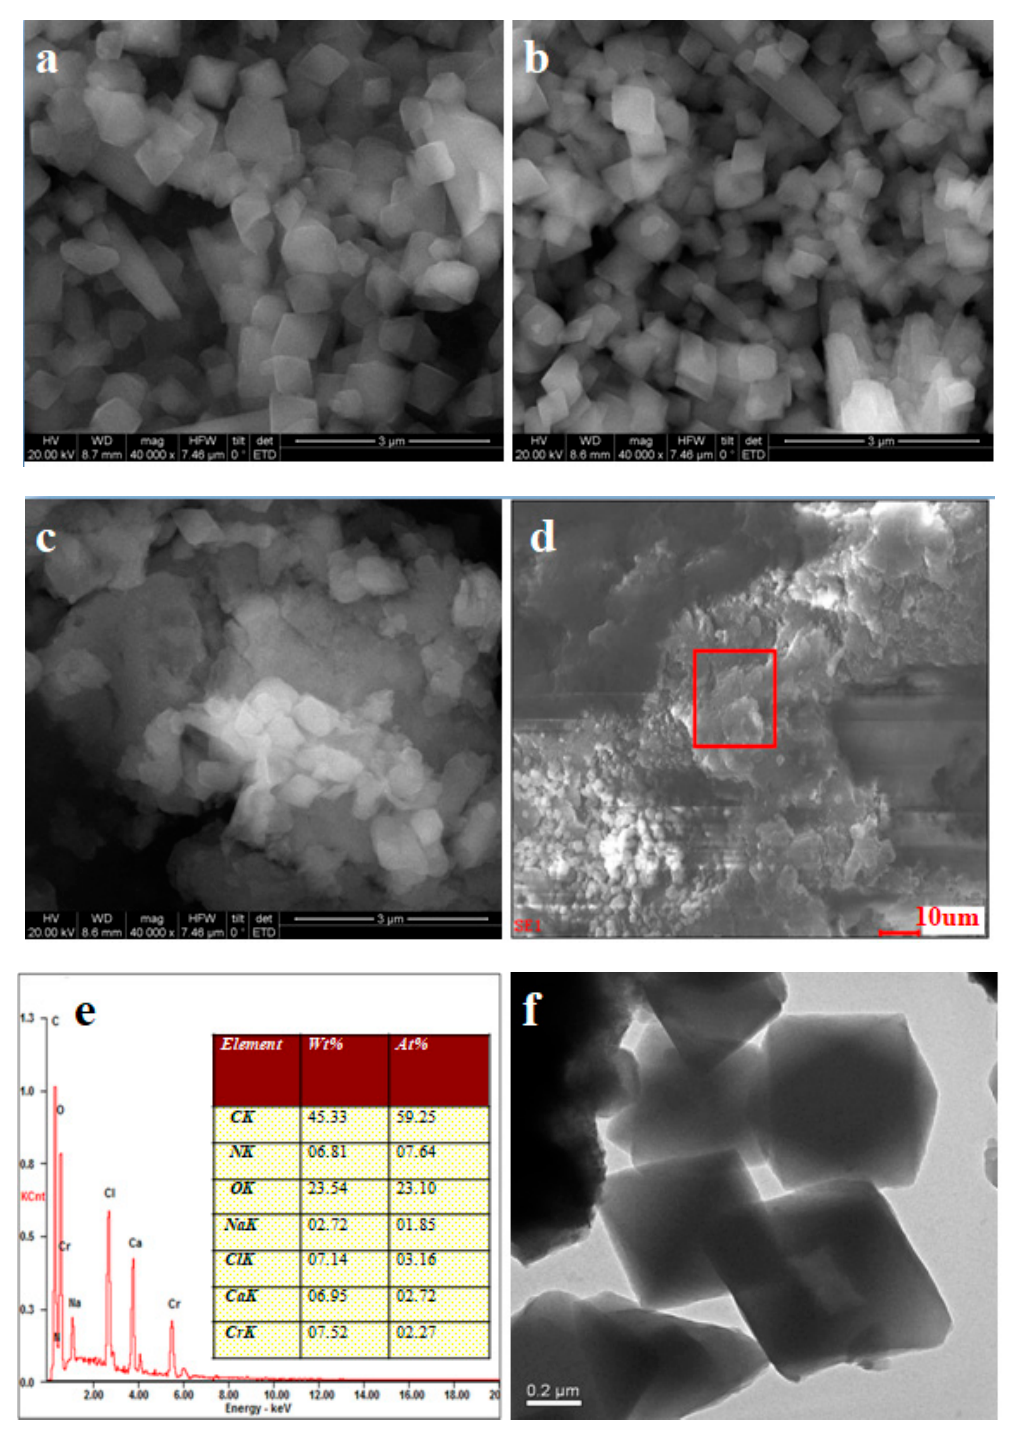
Figure 1. Scanning electron microscope (SEM) images of ( a ) MIL-101, ( b ) MIL-101-TEPA, and ( c ) MIL-101-TEPA@CA images at 3 μ m; ( d , e ) EDS analysis; ( f ) TEM image of MIL-101-TEPA@CA at 2 μ m. 101-TEPA@CA images at 3 µ m; ( d , e ) EDS analysis; ( f ) TEM image of MIL-101-TEPA@CA at 2 µ